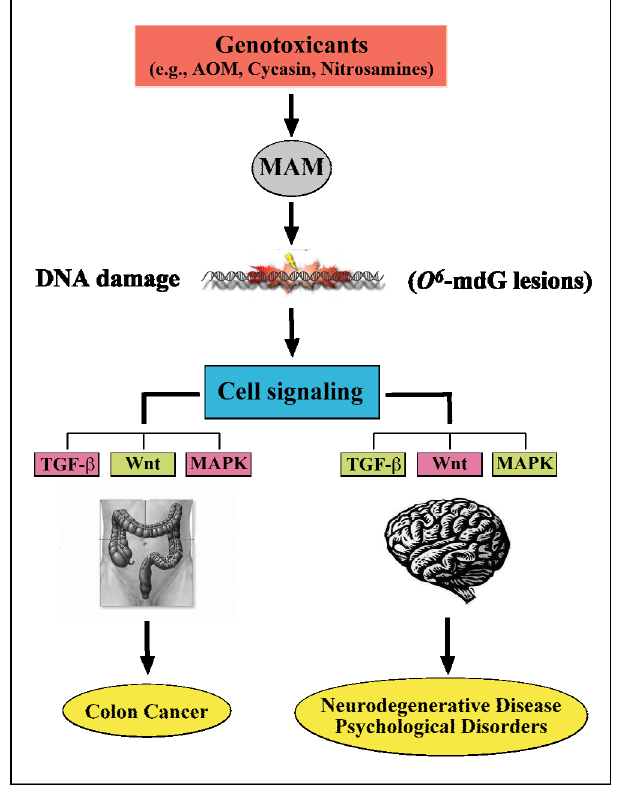
Figure 9. Proposed relationship between MAM-induced colon cancer and brain disease/disorders. Genotoxins, such as methylazoxymethanol (MAM), that induce O 6 -methyldeoxyguanine lesions ( O 6 -mdG DNA damage), disturb cell signaling pathways, including transforming growth factor-  (TGF-  ), wingless and proto-oncogene Int-1 (Wnt), and mitogen-activated protein kinase (MAPK). In general, the literature supports up-regulation (green) and down-regulation (pink) in association with the two distinct phenotypes. (Modified from Chen and Huang [112]). Thus, MAM may have opposing effects that depend on the mitotic state of the cell: whereas the agent may induce mutagenesis and proliferation (tumorgenesis) in cycling cells, in non-cycling cells ( i.e. , neurons) the outcome is cellular